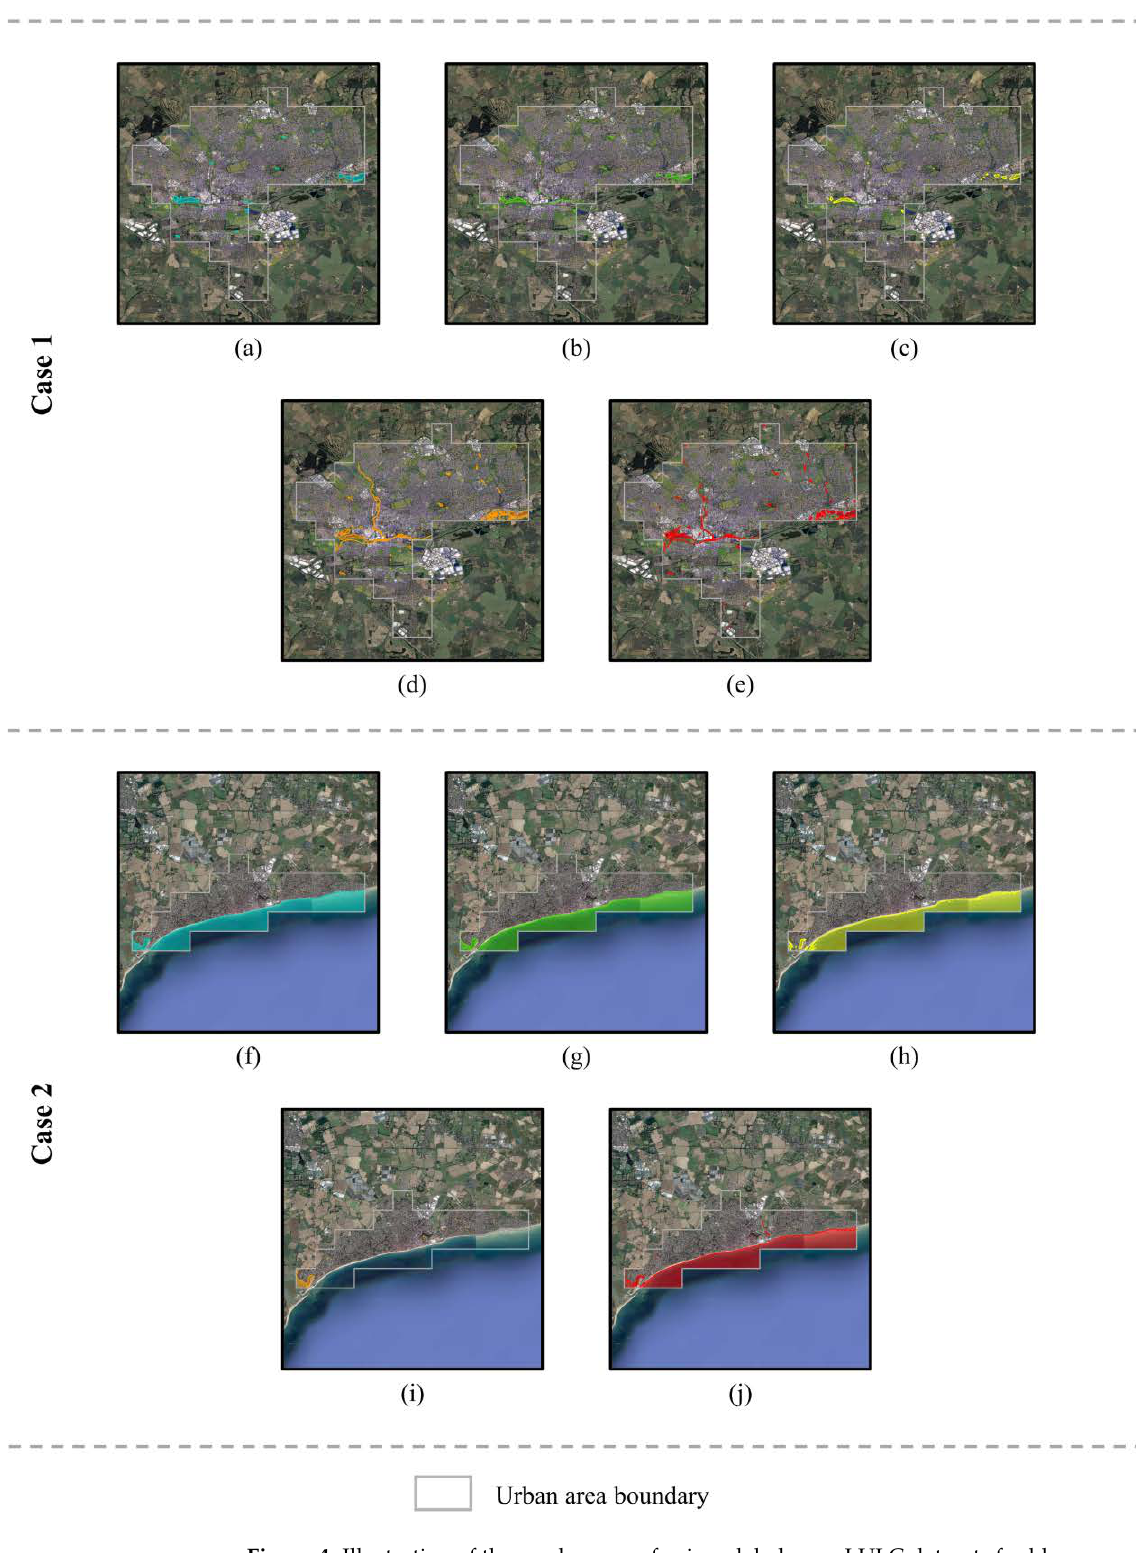
Figure 4. Illustration of the weaknesses of using global open LULC datasets for blue space mapping: ( a ) Northampton, ESRI; ( b ) Northampton, ESA; ( c ) Northampton, FROM-GLC10; ( d ) Northampton, OSM; ( e ) Northampton, reference; ( f ) Bognor Regis, ESRI; ( g ) Bognor Regis, ESA; ( h ) Bognor Regis, FROM-GLC10; ( i ) Bognor Regis, OSM; ( j ) Bognor Regis, reference.